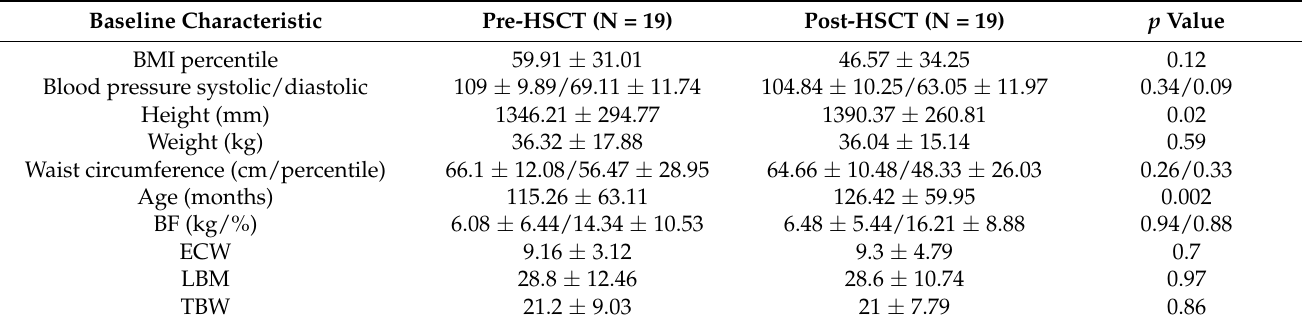
Table 1. Anthropometric characteristics of the study group (mean ± standard